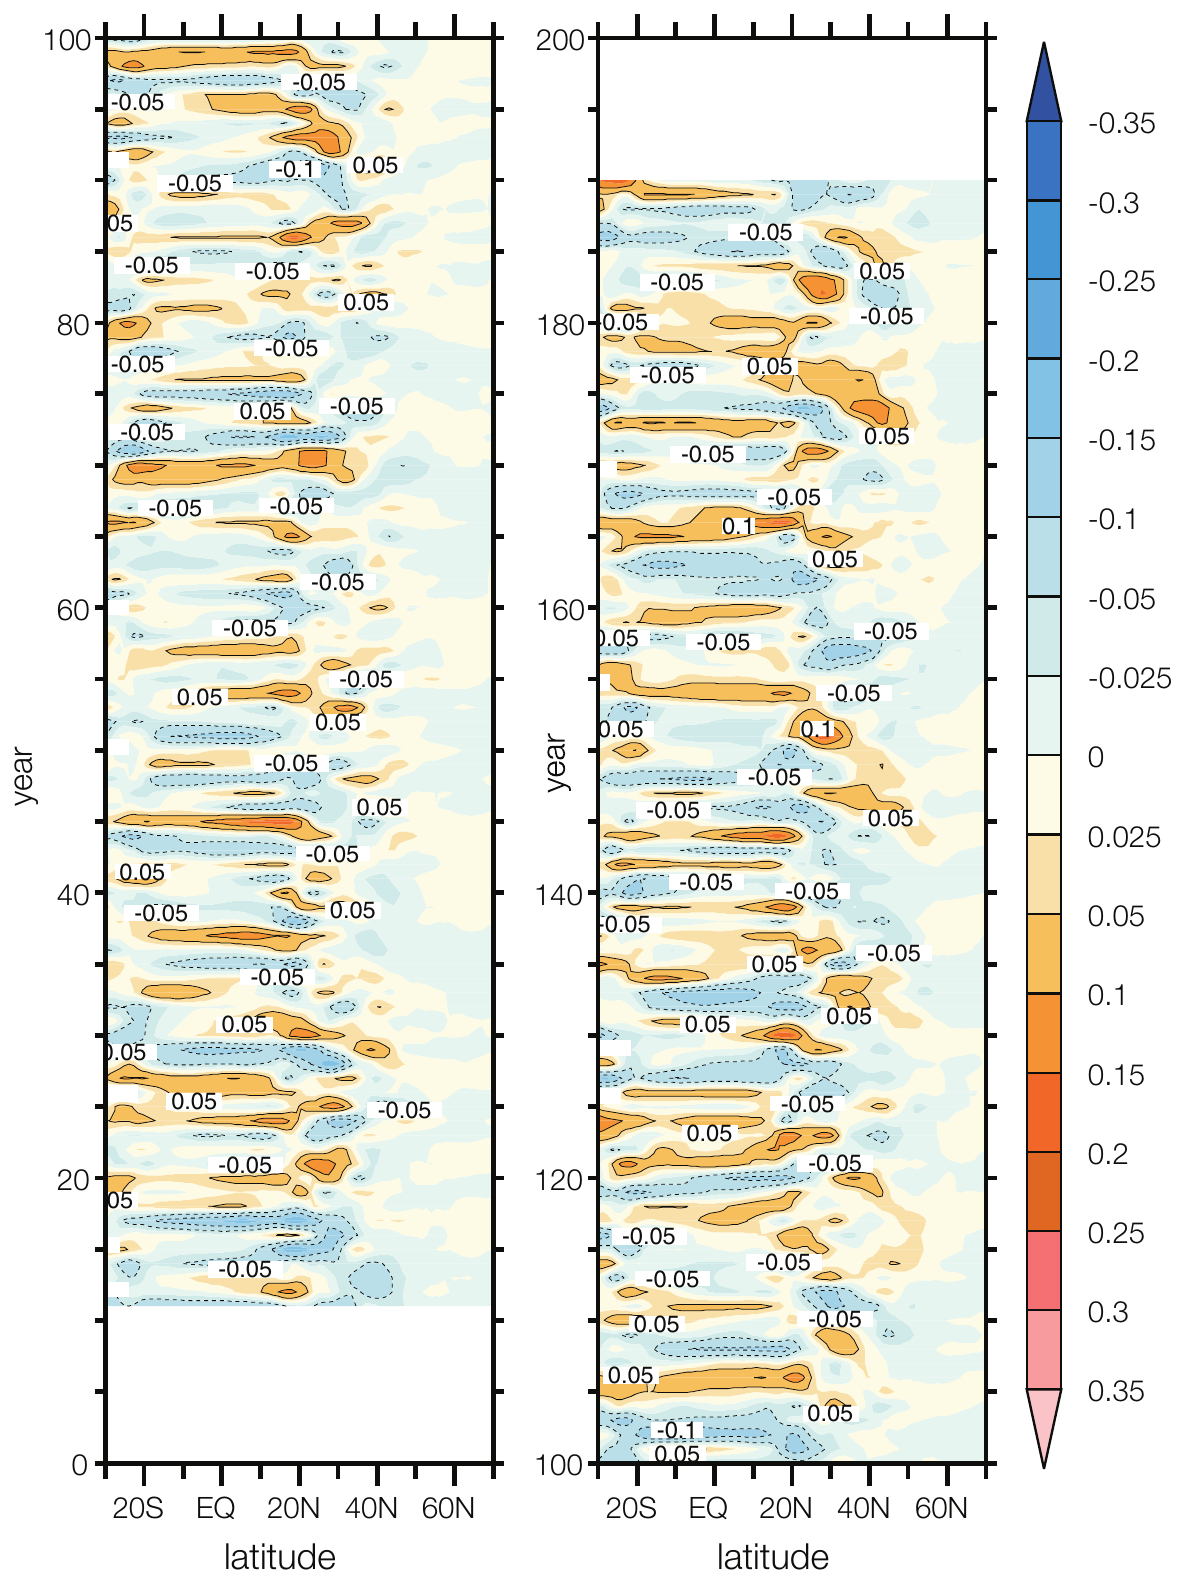
Fig. 5. Latitude-time evolution of the ocean heat transport anomalies (PW: 10 15 W) in Atlantic for the ECHAM4T30/ OPA simulation. Positive anomalies are in full lines and negative ones in dashed